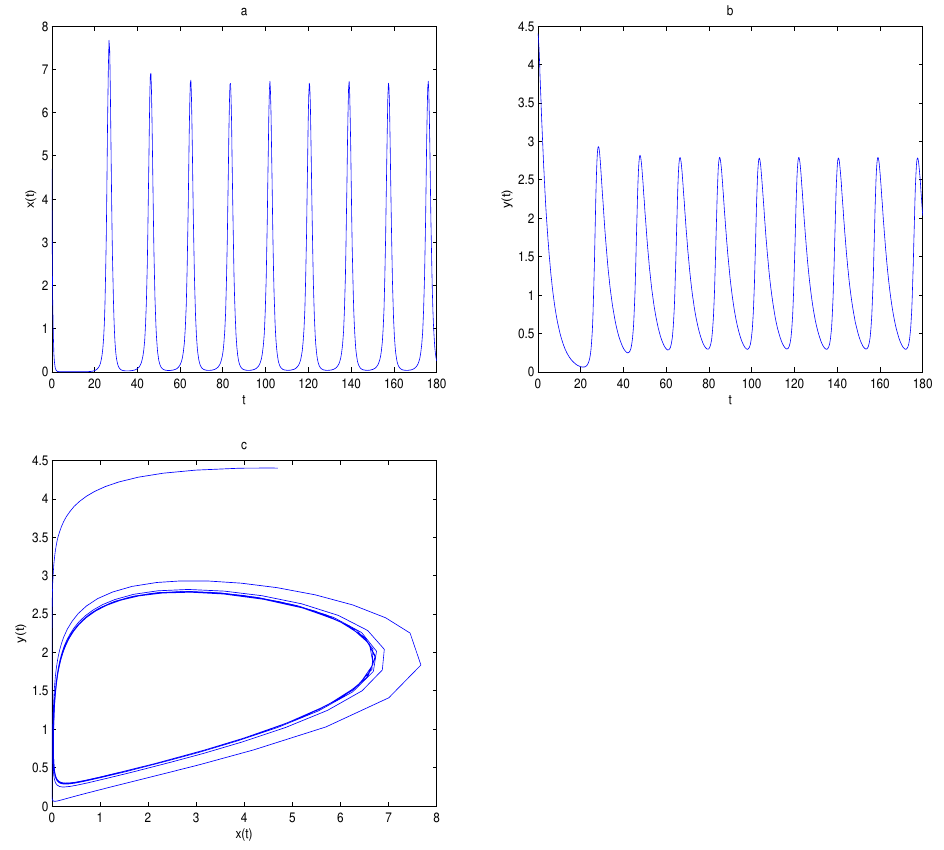
Figure 6. There exists a limit cycle in Ω when r = 1.888, ω = 0.9, b = 1, c = 1.213, α = 0.22. A 1 = ( 1.574,1.574 ) . Subfigure ( a ) is time series of x ( t ) , subfigure ( b ) is time series of y ( t ) , and subfigure ( c ) is phase diagram of system